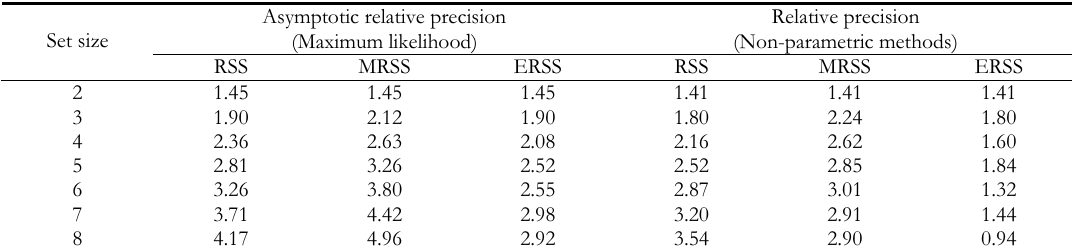
The asymptotic relative precision and relative precision values for estimators of the scale parameter from Gamma (3.0) Asymptotic relative precision (Maximum likelihood)